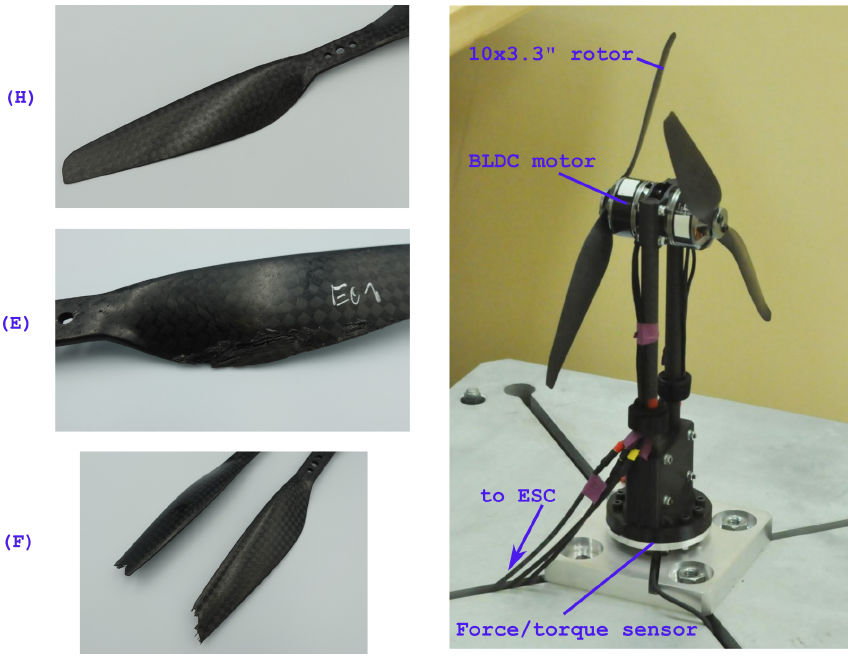
Figure 1. Samples of rotors used in fault detection experiments and overview of the propulsion test rig.